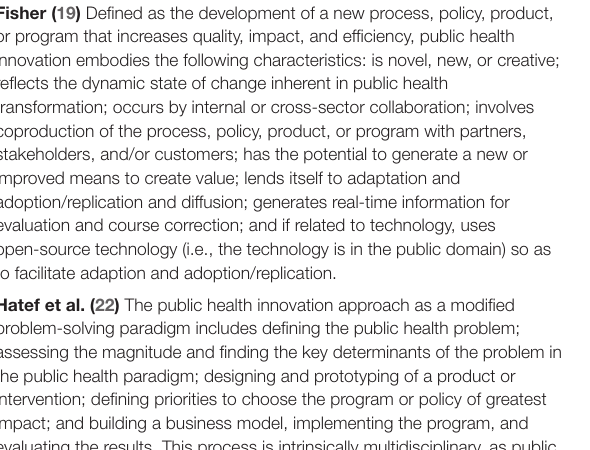
TABLE 2 | Approaches to defining public health innovation.